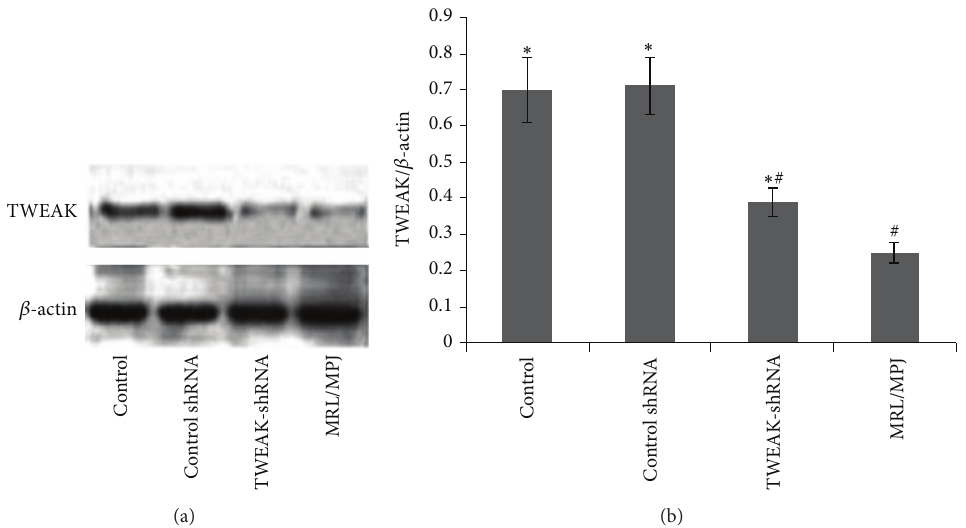
Figure 2: The expression of TWEAK protein in the kidneys. Total lysates of kidneys were collected for Western blotting to measure TWEAK protein expression. The representative experiment was presented (a). The ratios of TWEAK/ 𝛽 -actin IOD were shown (b). Control: MRL/lpr mice treated with PBS; Control shRNA: MRL/lpr mice treated with LV-Control shRNA; TWEAK-shRNA: MRL/lpr mice treated with LV- TWEAK-shRNA; and MRL/MPJ: MRL/MPJ mice as normal control. The error bars represent the standard deviation. ∗ 𝑝 < 0.05 versus MRL/MPJ mice and # 𝑝 < 0.05 versus control MRL/lpr mice.